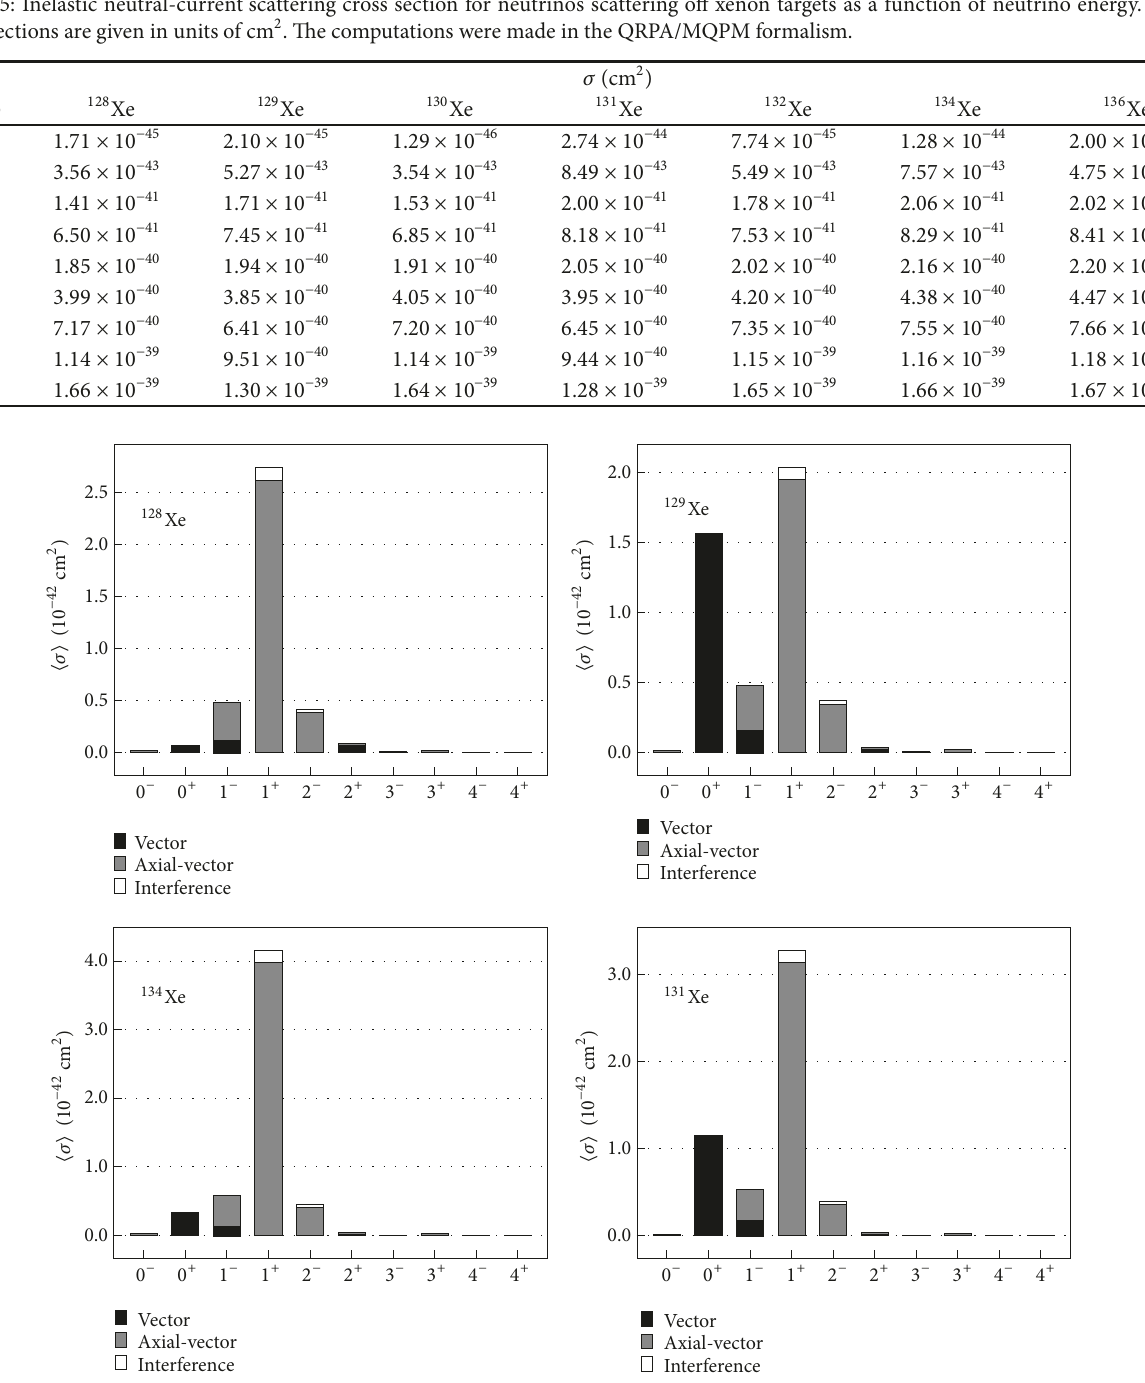
Figure 4: The contributions of multipole channels 𝐽 ≤ 4 to the total averaged cross section for inelastic scattering of supernova electron neutrinos. Bar plots are shown for a representative sample of 128 Xe (top left), 129 Xe (top right), 134 Xe (bottom left), and 131 Xe (bottom right). A division to vector, axial-vector, and interference parts of the interaction is shown. Cross sections are given in units of 10 −42 cm 2